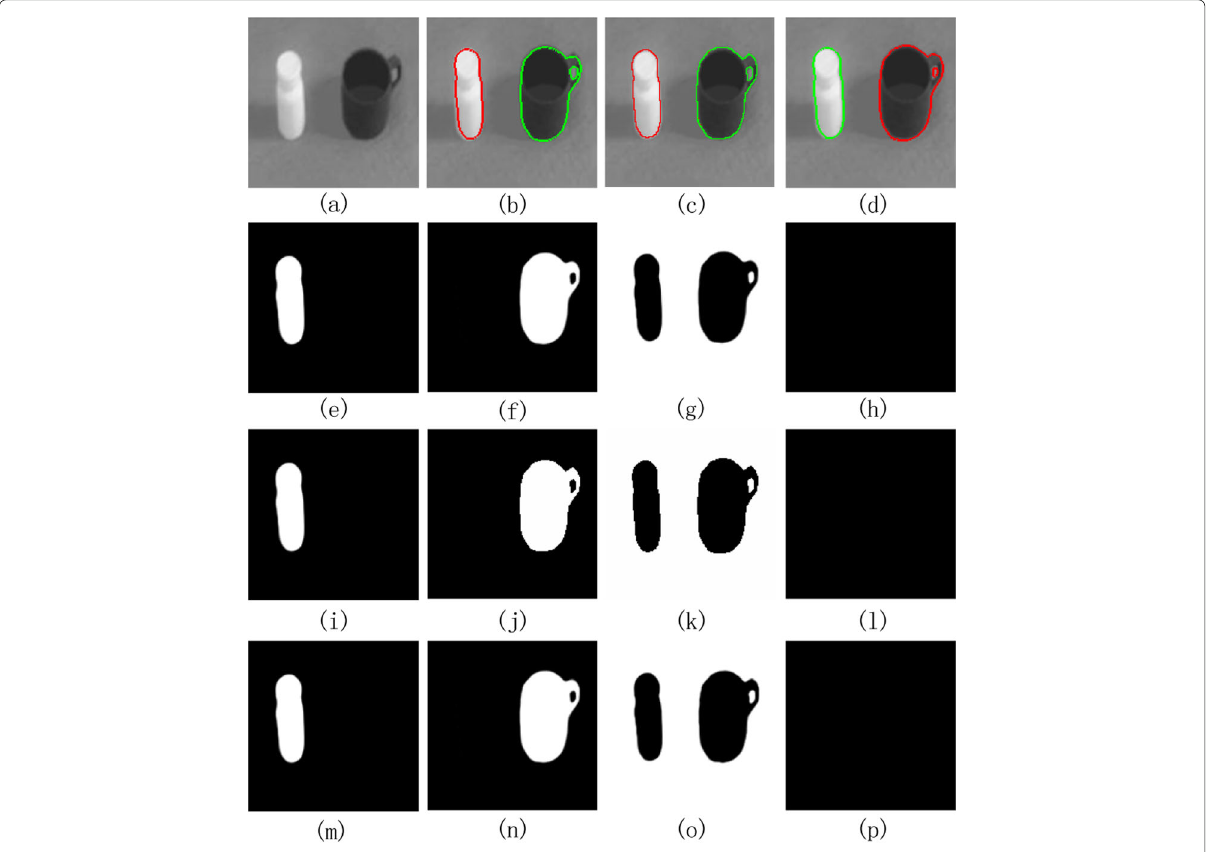
Fig. 4 Comparison of original Vese-Chan method, TV regularization method, and our method using two label functions. a The input nature image. b The segmentation of original Vese-Chan method. c The segmentation of TV regularization method. d The segmentation of our method. e – h Different regions obtained via the original Vese-Chan method. i – l Different regions obtained via TV regularization method. m – p Different regions obtained via our